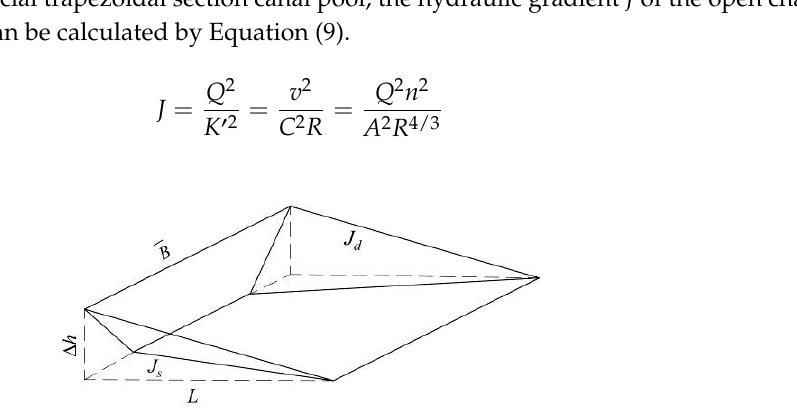
Figure 3. Schematic diagram of wedge-shaped water body.